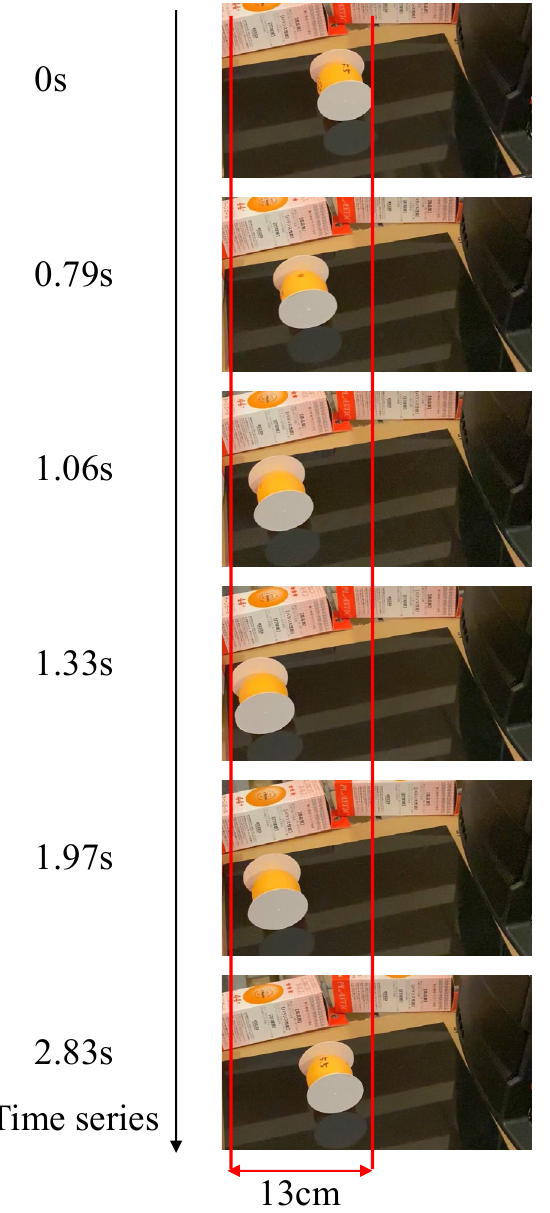
Figure 12. Actual movement of a ball with wheels.